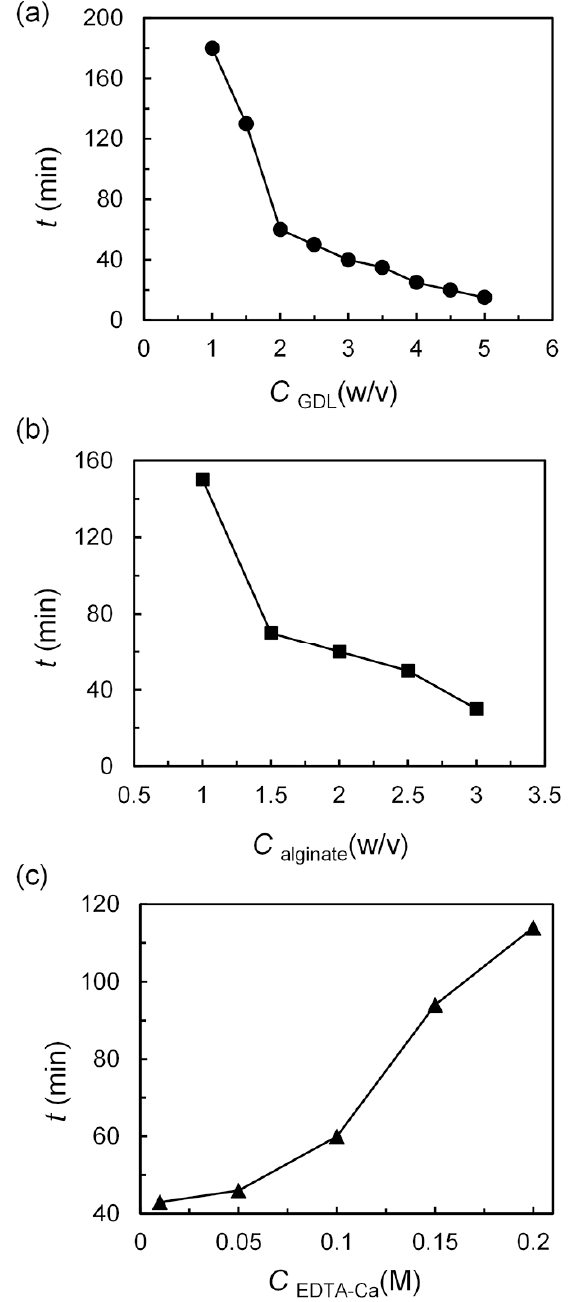
Figure 3. The influence of GDL ( a ), sodium alginate ( b ), and EDTA-Ca ( c ) on the gelling time. When sodium alginate and EDTA-Ca are fixed at 2% ( w / v ) and 0.1 M, respectively, the gelling time decreases along with the increasing of GDL concentration (Figures 3a and